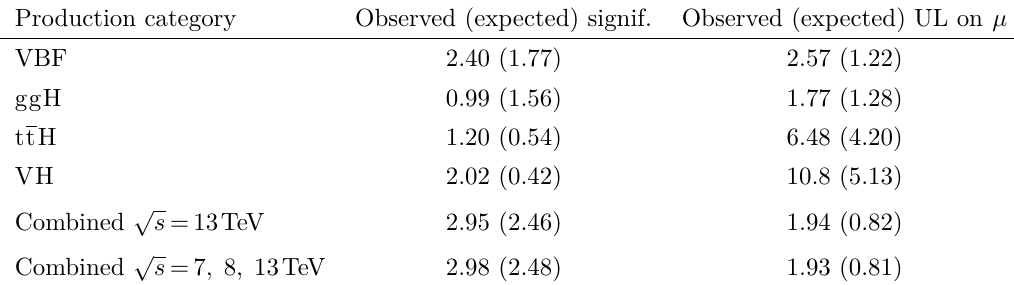
Table 10 . Observed and expected significances for the incompatibility with the background-only hypothesis for m = 125 . 38 GeV and the corresponding 95% CL upper limits on µ (in the absence H of H → µ + µ − decays) for each production category, as well as for the 13 TeV and the 7+8+13 TeV combined fits.